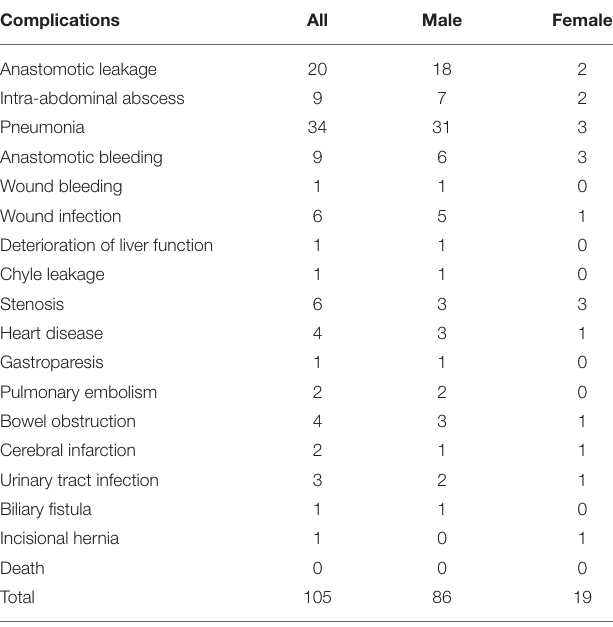
TABLE 5 | Postoperative complications.